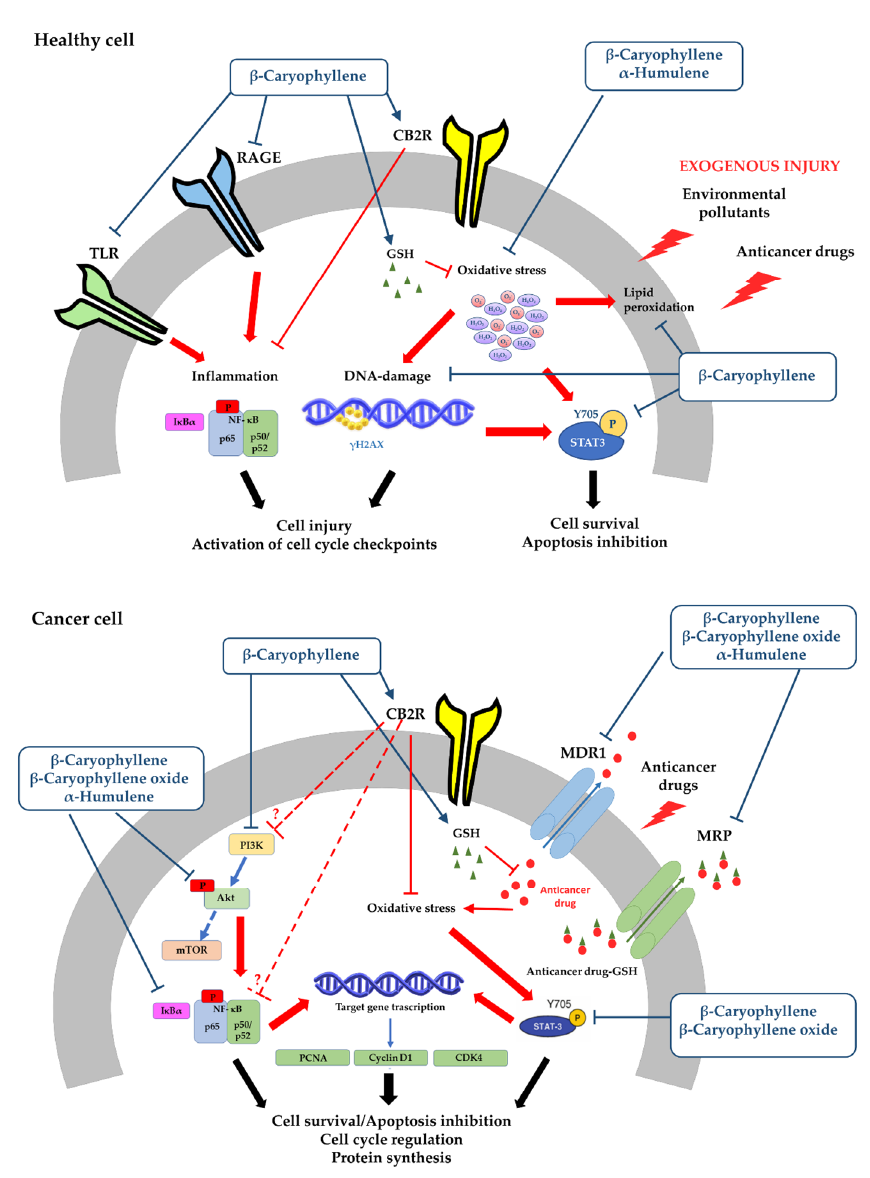
Figure 10. Pleiotropic and multitarget mechanisms involved in the chemopreventive properties of caryophyllane sesquiterpenes in healthy and cancer cells. The activation of CB2R is associated with the antioxidant and anti-inflammatory effects of β-caryophyllene in healthy cells. Moreover, its role in the modulation of inflammatory process and oxidative stress in cancer cells require more investigations. CB2R, CB2 receptor; TLR, Toll-killer receptor; RAGE, receptor for advanced glycation end products; GSH, glutathione; STAT3, signal transducer and activator of transcription 3; γH2AX, phosphorylated (Ser139) histone 2AX; NF-kB, nuclear factor kappa B; PI3K, phosphatidylinositol 3-kinase; Akt, protein kinase B; mTOR, mammalian target of rapamycin; PCNA, proliferating cell nuclear antigen; CDK4, cyclin-dependent protein kinase 4; MDR1, multidrug resistance; MRP, multidrug resistance-associated protein.